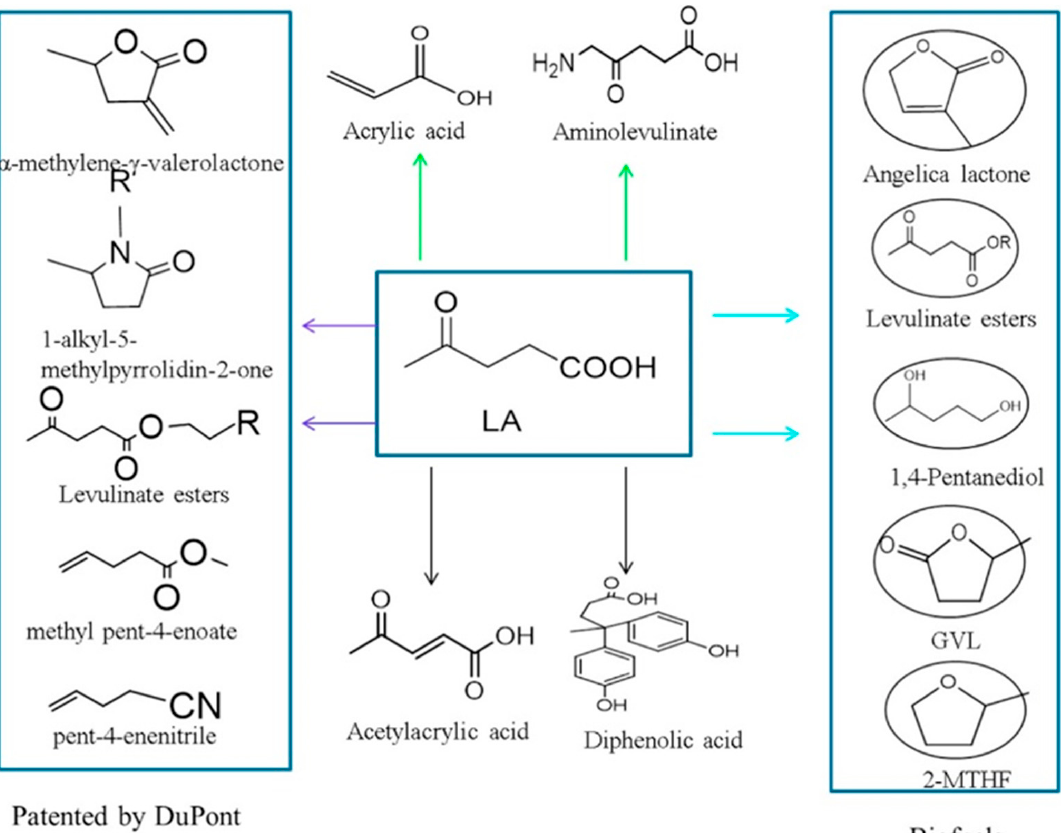
Figure 8. Levulinic acid as platform molecule for value-added chemicals. Reproduced with permis- sion from ref. [108] Copyright © 2015 Elsevier Ltd. All rights reserved.